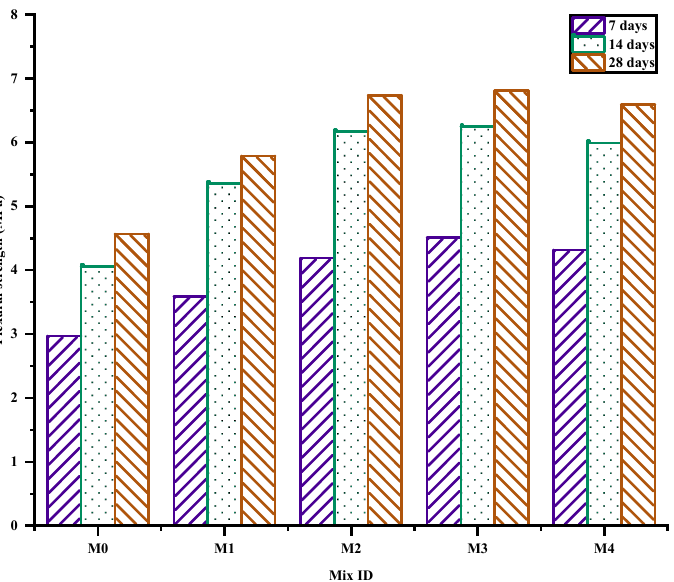
Figure 4. Flexural strength of fine-grained cementitious composites with different percentages of fibers for five different mixes.